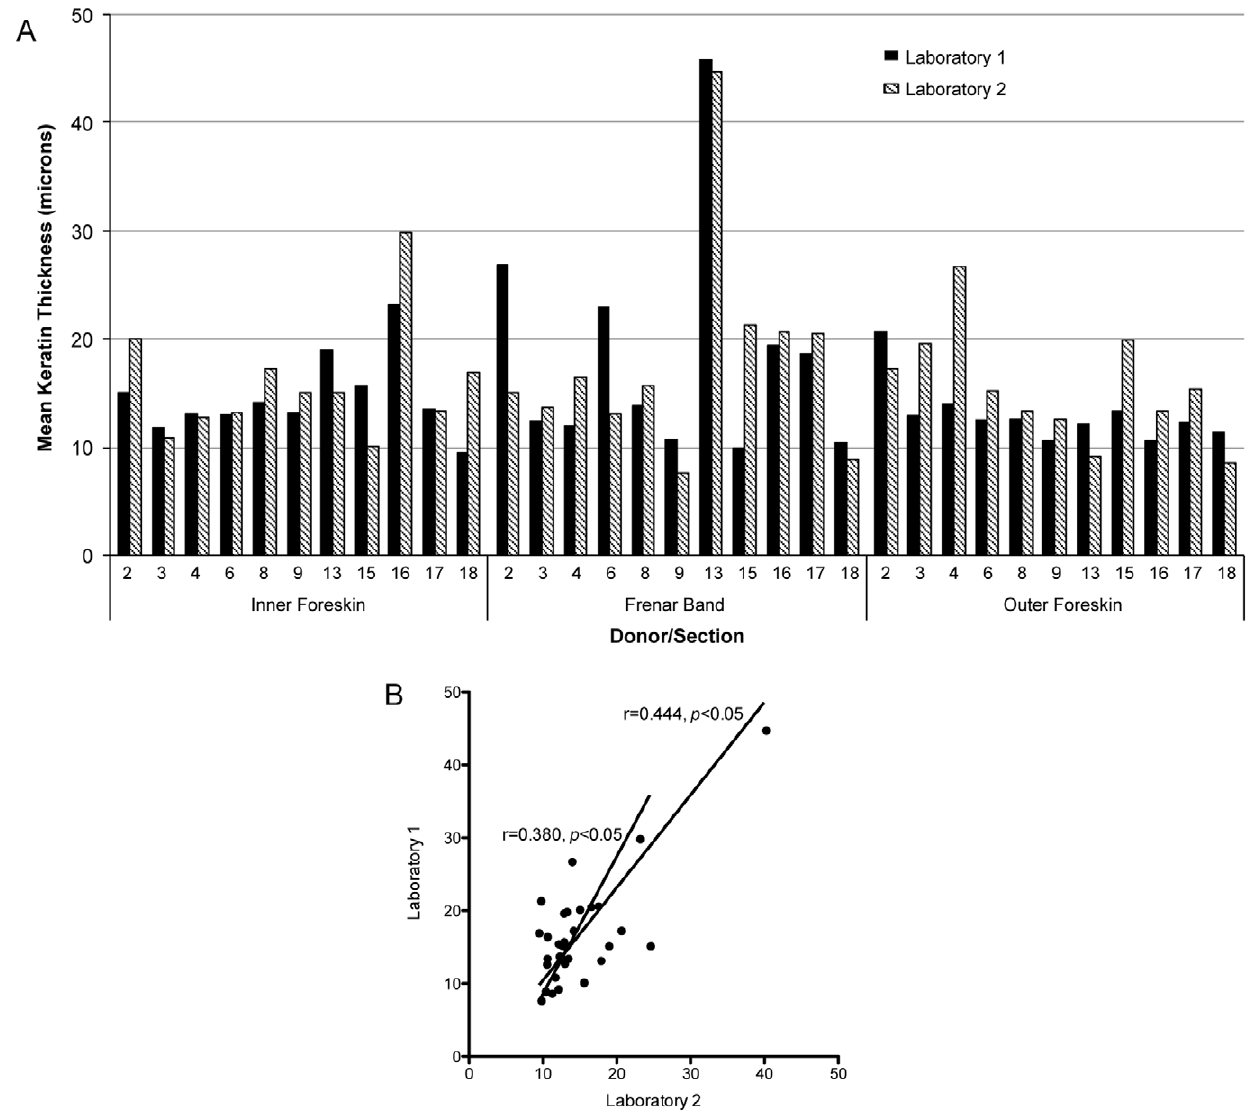
Figure 3. Data obtained from two independent laboratories. (A) Mean thicknesses recorded by laboratory 1 (black bars) and laboratory 2 (hatched bars) for 11 donors. (B) Spearman rank correlation of two laboratory measurements. Shorter line = correlation coefficient calculated excluding donor sample # 13.